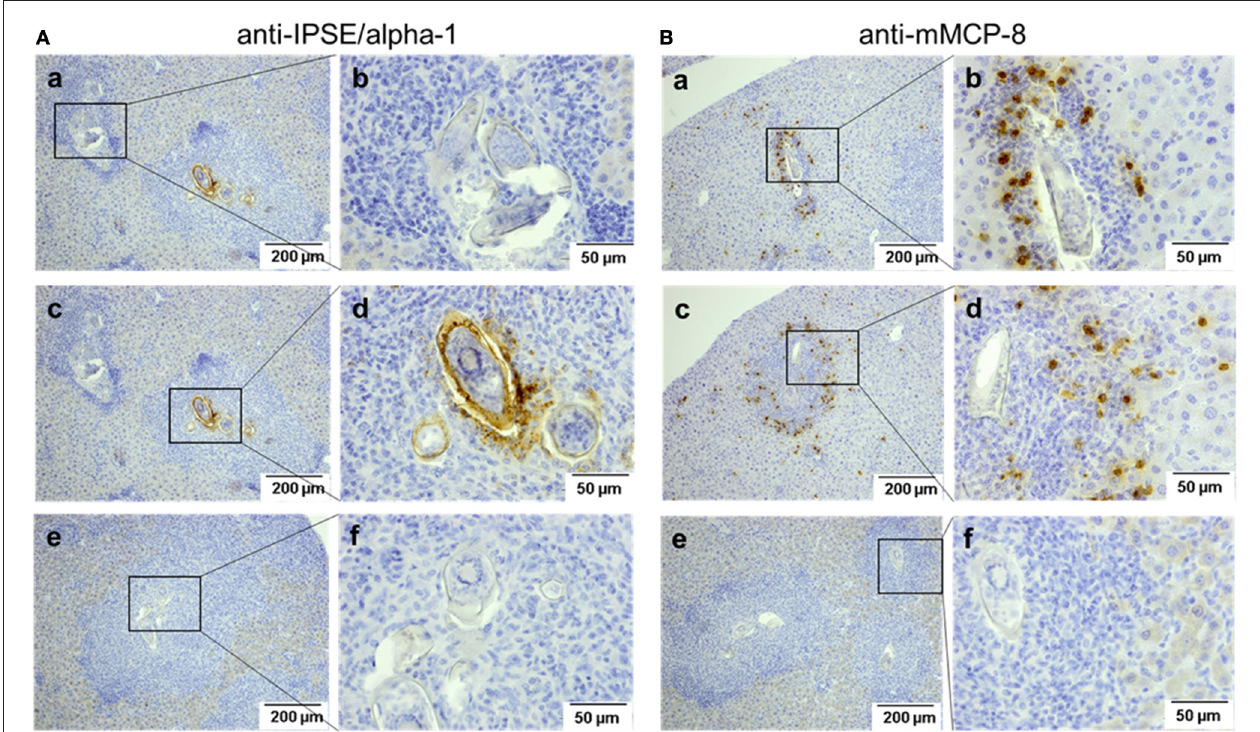
FIGURE 6 | Detection of IPSE/alpha-1 and basophils in schistosome egg granulomas. Sections of S. mansoni -infected murine liver were stained for IPSE/alpha-1 (anti-IPSE/alpha-1; A ) and basophils (anti-mMCP-8; B ). Depicted are two magnification, each. Scale bars are 200 µ m for 100x magnification and 50 µ m for 400x magnification. (a,b) Show small granulomas with presumably immature eggs without IPSE/alpha-1 production (A a, left box, A b ) and with basophils detected near the egg (B a, B b ) . (c,d) Show advanced granulomas with strong IPSE/alpha-1 staining in the subshell area and outside the eggs (A c right box, A d ) and with basophils detected mainly in the outer rim of the granuloma (B c,d ) . (e,f) Show negative controls without the respective primary antibodies.